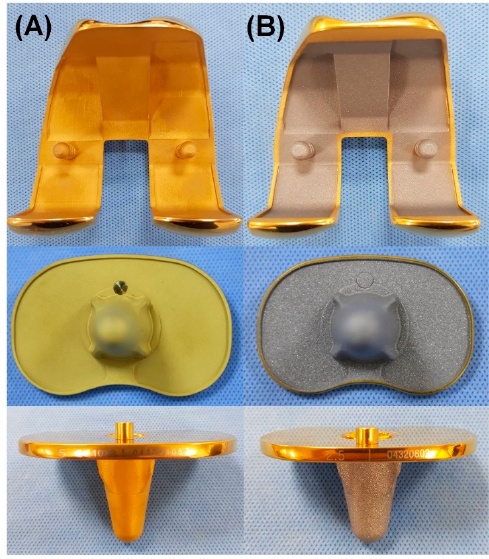
Figure 2. Photograph of Buechel and Pappas knee prosthesis (L-F Knee System, Cellumed Co., Ltd., Seoul, Korea) used in this study. The undersurface of the prosthesis was changed from ( A ) to ( B ) in late 2013.